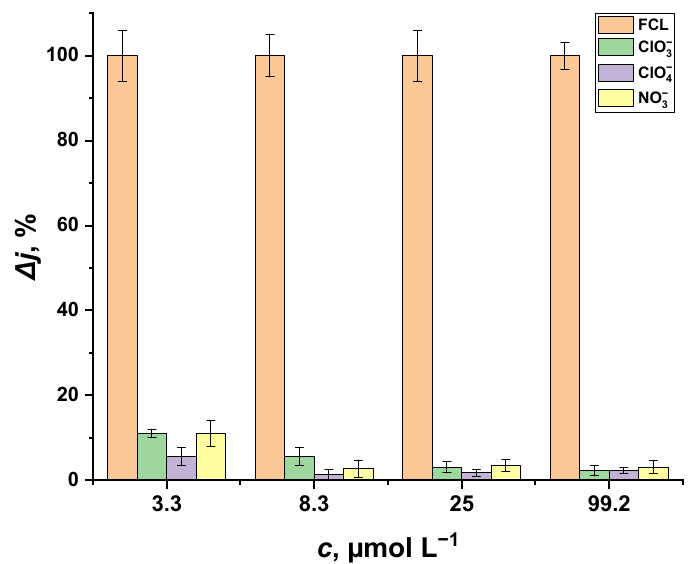
Figure 7. Percentage of change in current ( ∆ j ) obtained for the glass|FTO|PB sensor in PBS containing various concentrations of ClO − , ClO − and NO − ions. Bias potential: 0 V vs. Ag|AgCl, KCl sat . 3 4 3